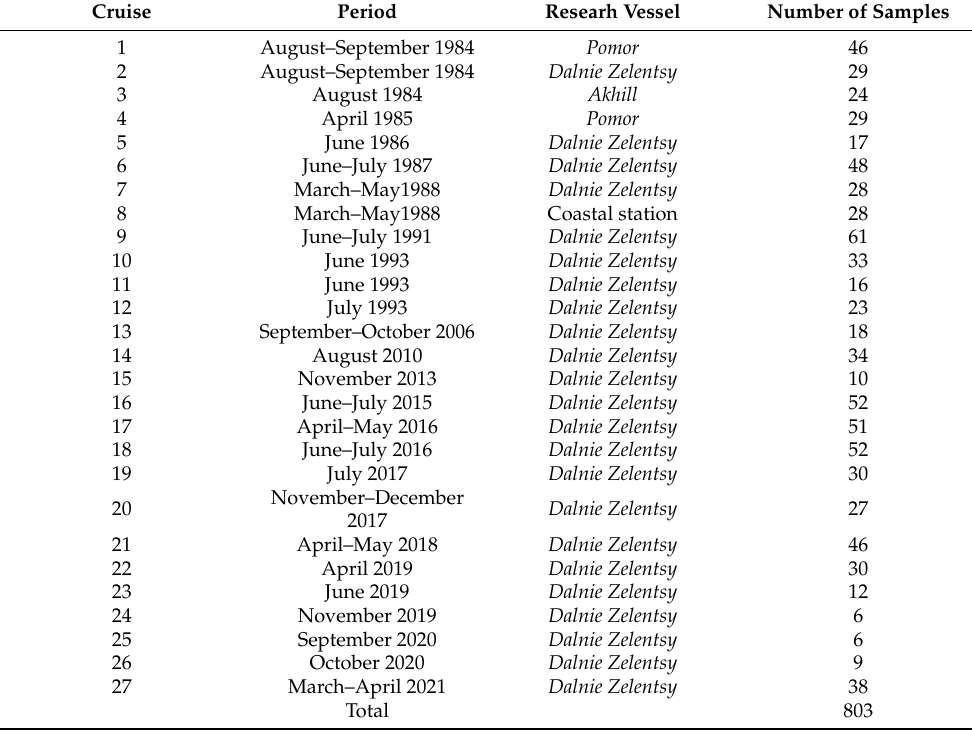
Table 1. List of cruises for Chl-a in the Barents Sea,